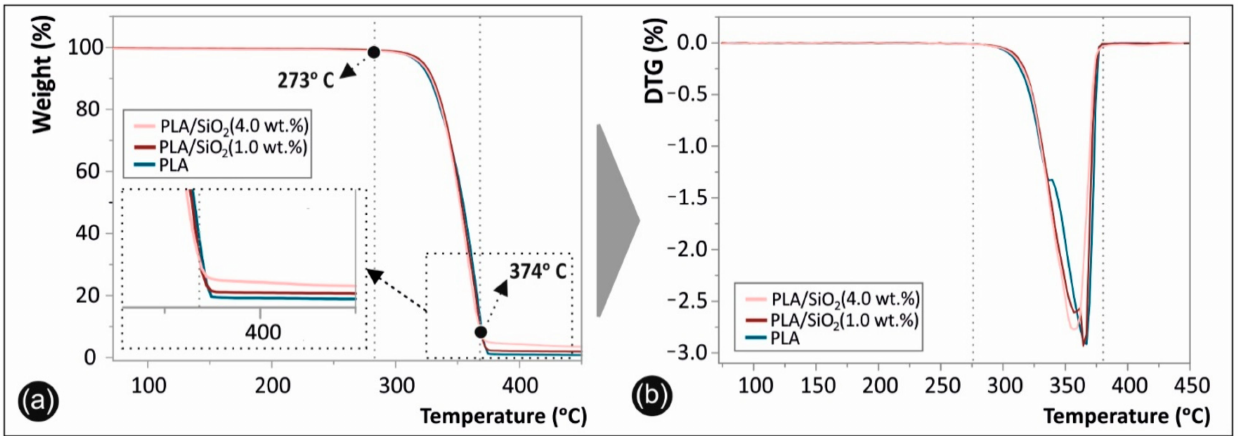
Figure 8. ( a ) Thermogravimetric analysis (TGA) and ( b ) Differential thermogravimetry (DTG) plots of 3D printed neat PLA and PLA/SiO 2 nanocomposites at 1.0 and 4.0 wt.% filler loading (the inset in Figure 8a shows more specifically the materials weight loss as remnant from 374 ◦ C that all polymeric substance has been decomposed and up to 450 ◦ C, corresponding to the SiO 2